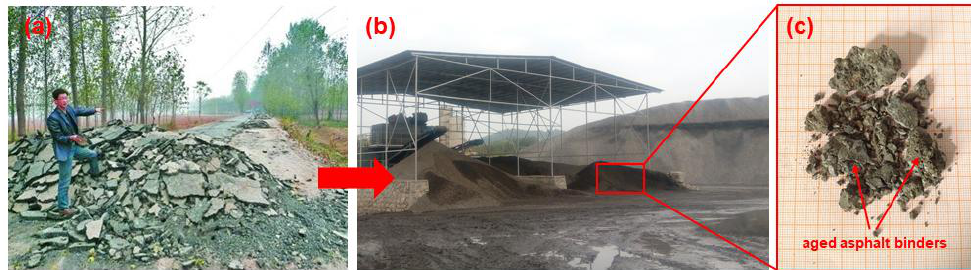
Figure 1. Pavement materials which have reached the end of their service life: ( a ) Waste asphalt concrete form old pavement; ( b ) Reclaimed asphalt pavement materials; ( c ) Aged asphalt binders covered with aggregate.